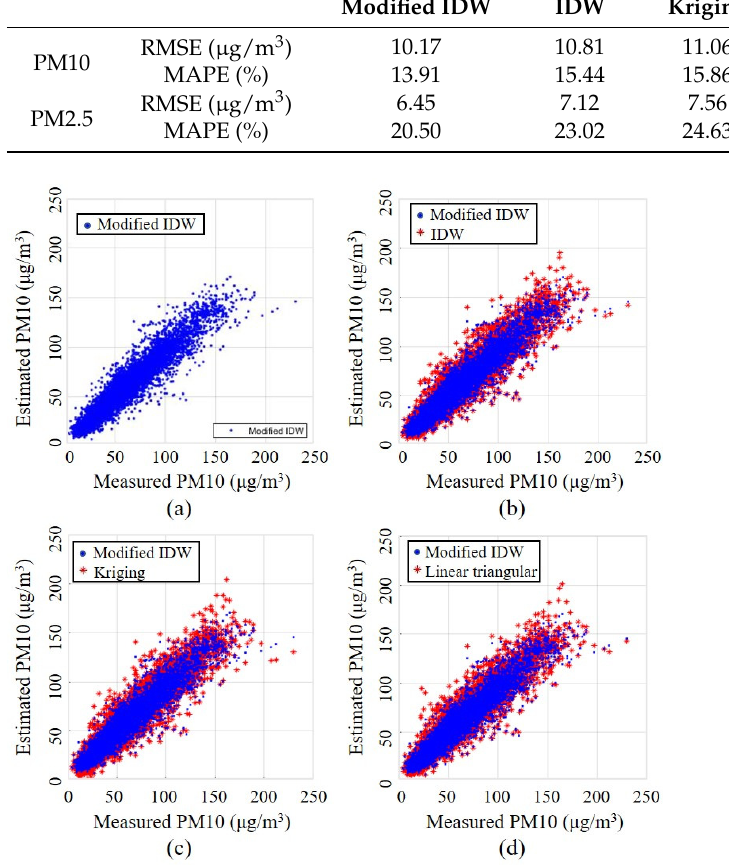
Figure 4. Comparison between estimated and observed PM10 values: ( a ) modified IDW, ( b ) IDW and modified IDW, ( c ) kriging and modified IDW, and ( d ) linear triangular and modified IDW.